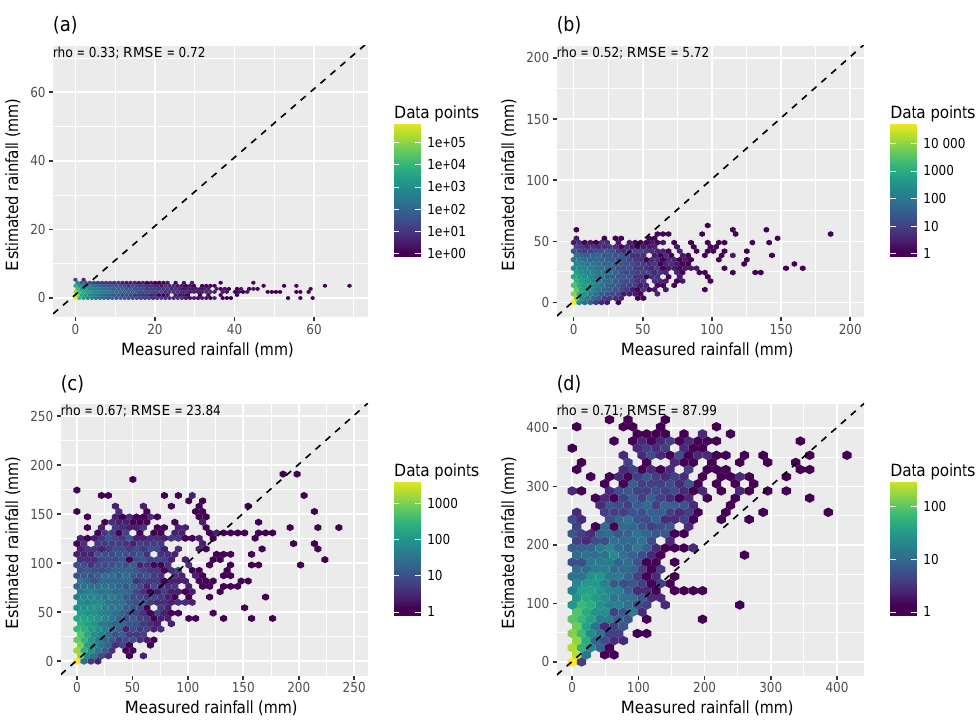
Figure 6. Validation of estimated rainfall quantities for 2013 at (a) hourly resolution and on the different aggregation levels: (b) daily, (c) weekly, (d) monthly. Each of the data points represents a station at the respective level of temporal aggregation. Rho represents the average correlation for each time step of the respective aggregation level. For an easy visual interpretation, the data are presented via hexagon binning in which the number of data points falling in each hexagon are depicted by